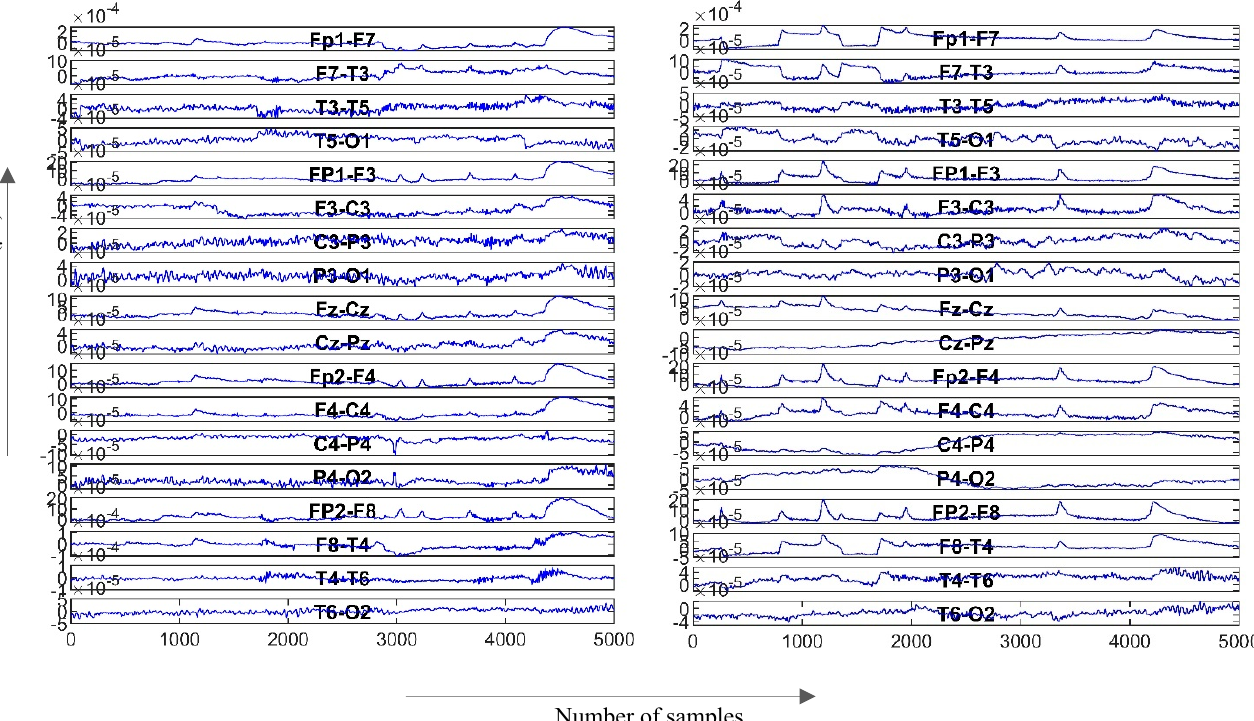
Figure 4. Generalized epilepsy (left) and TLE (right) samples based on the LB montage.